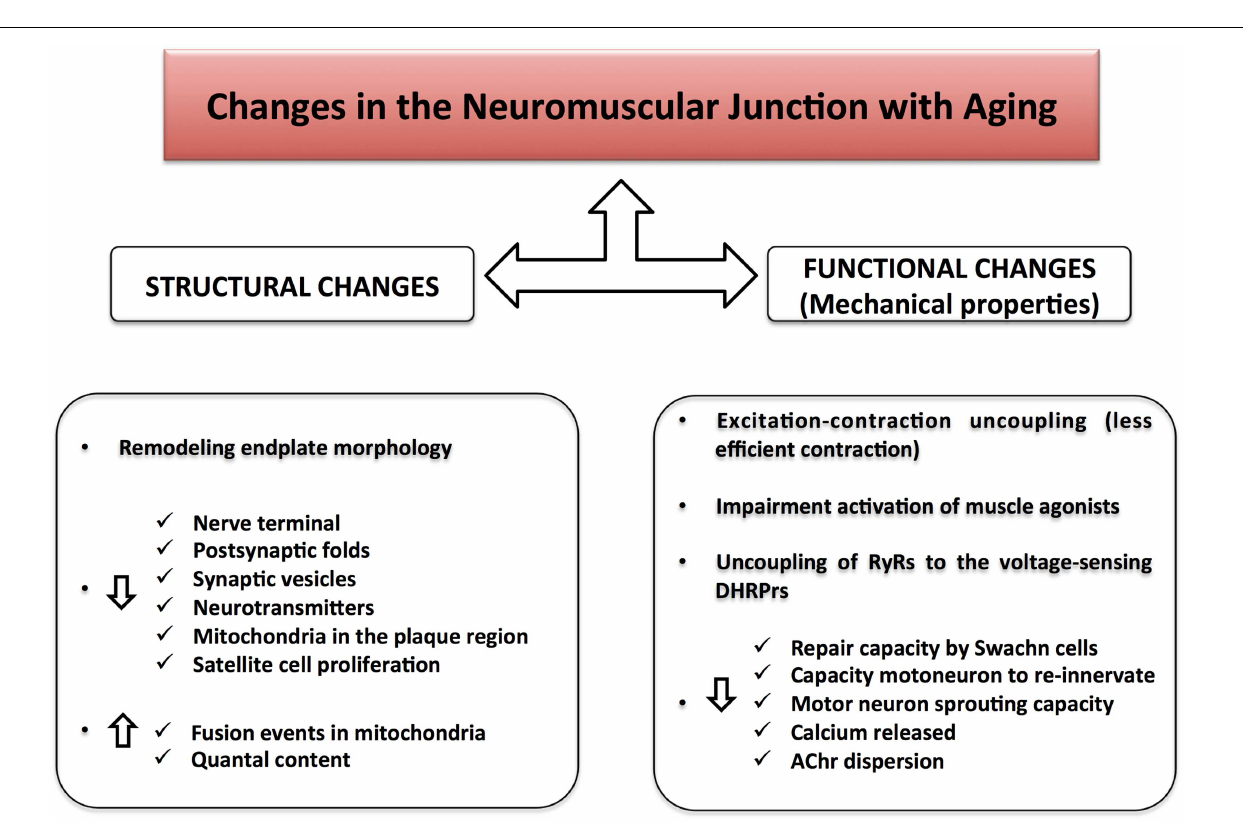
FIGURE 3 | Changes in the neuromuscular junction with aging . Structural changes together with functional alterations result in a NMJ impairment during aging.The excitation–contraction uncoupling leads to a loss of communication between the nervous and muscular system, causing a decline in skeletal muscle strength and muscle